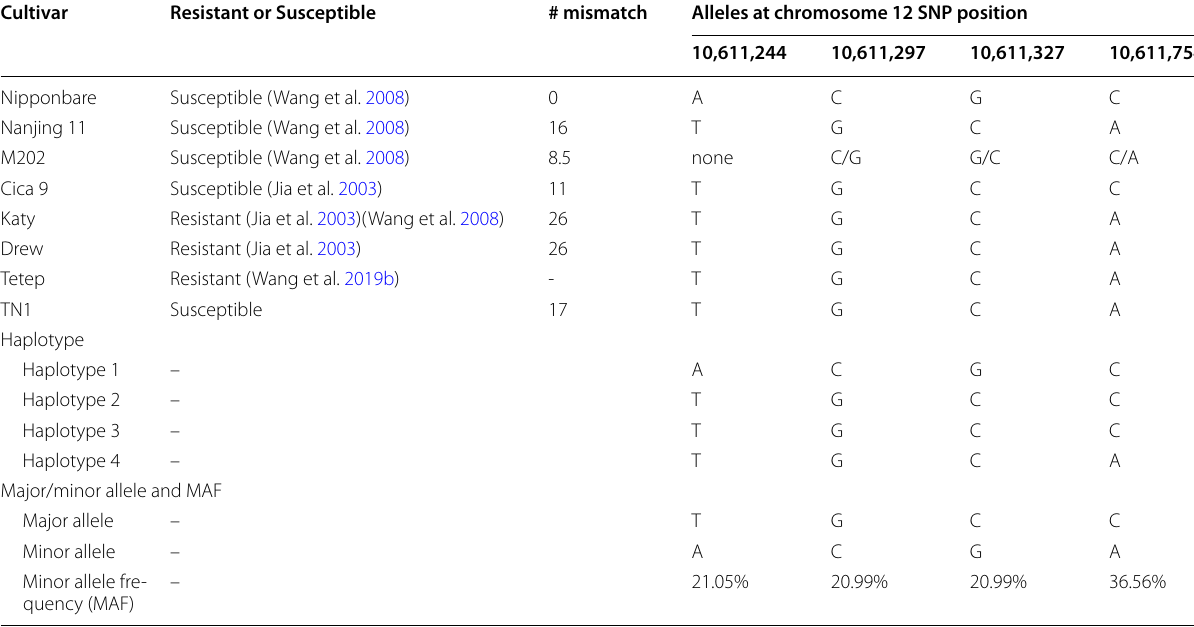
Table 3 Pi-ta alleles of blast susceptible and resistant cultivars at the same SNP position